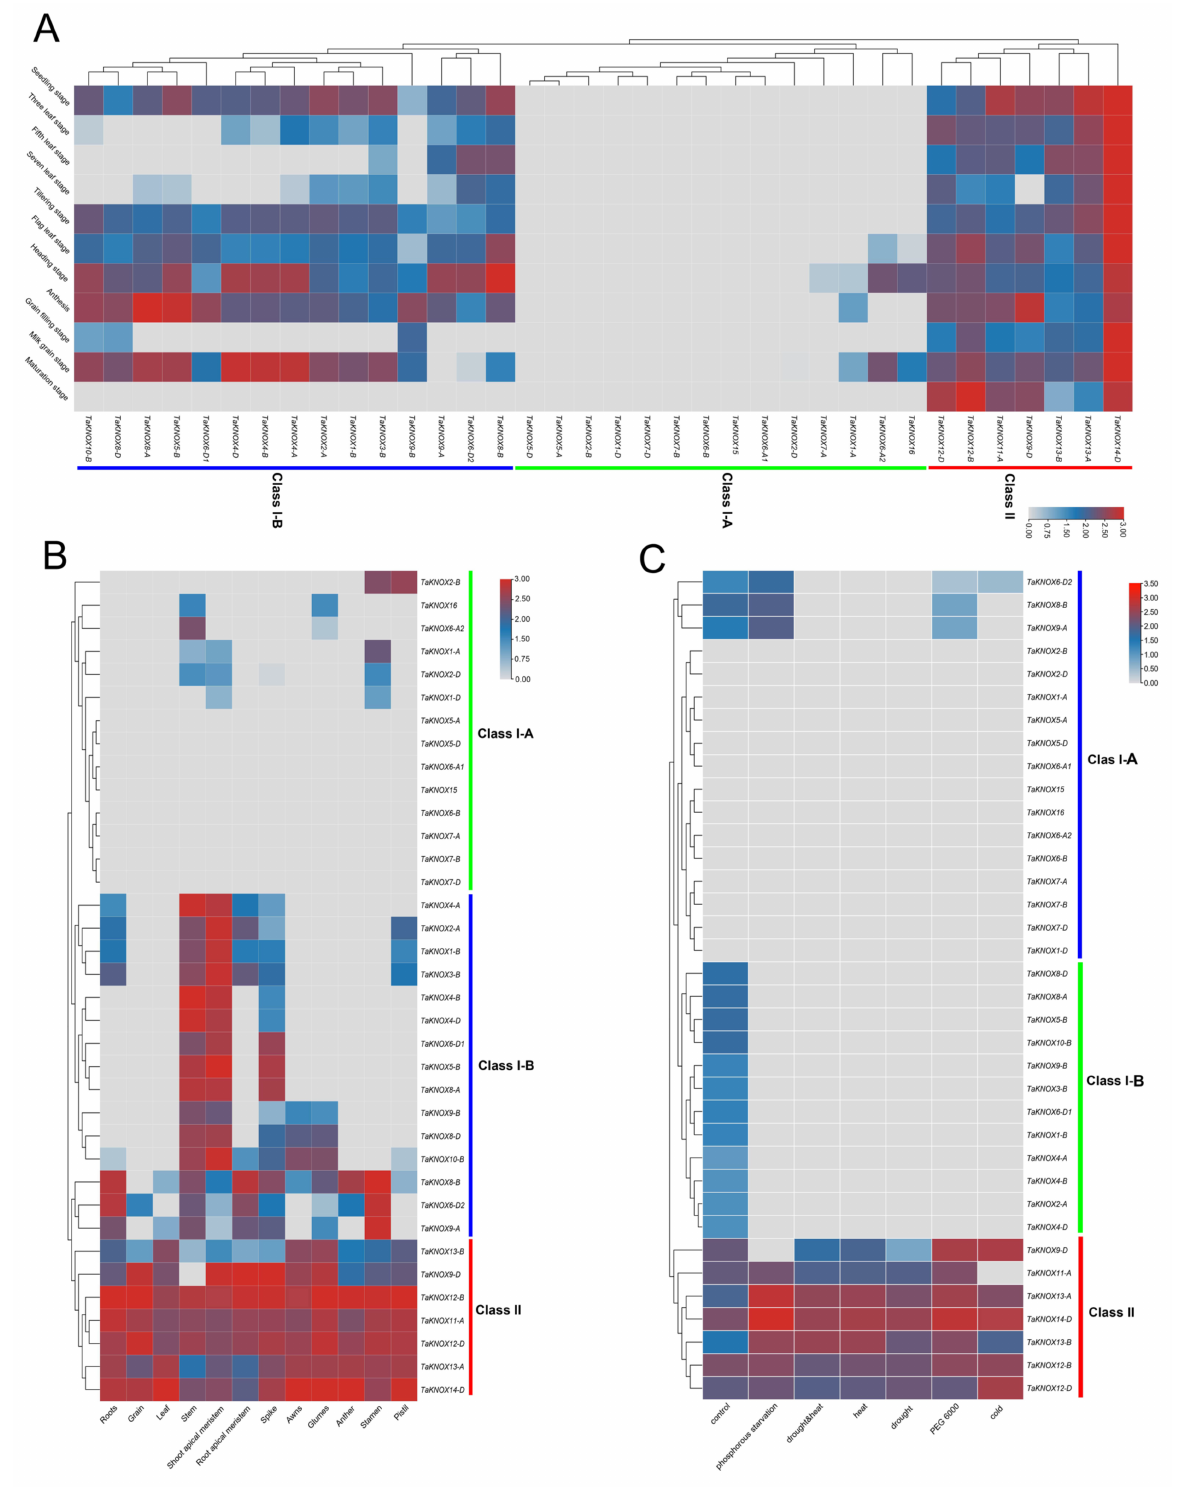
Figure 5. Heat map of the expression profiles of wheat TaKNOX genes at different wheat growth periods, different tissues and under different abiotic stresses. RNA-seq data of TaKNOX genes expression values of wheat growth period, tissues and under abiotic stresses were obtained from the wheat expression web. ( A ) The expression patterns of TaKNOX genes at different growth stages. ( B ) The expression pattern of TaKNOX genes in tissues. ( C ): The expression pattern of TaKNOX genes under different abiotic stresses. Different color lines represent different expression